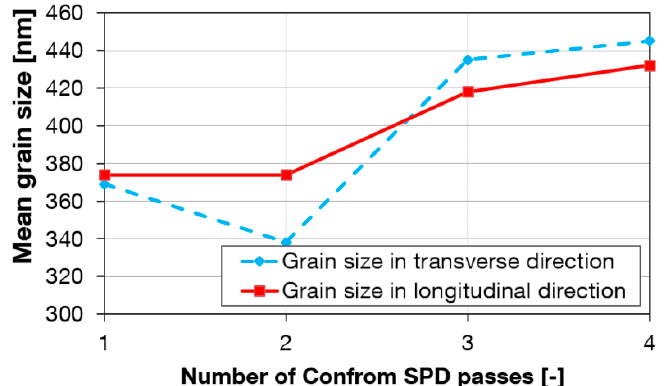
Figure 5. Mean grain size vs. number of passes through the Conform SPD machine.